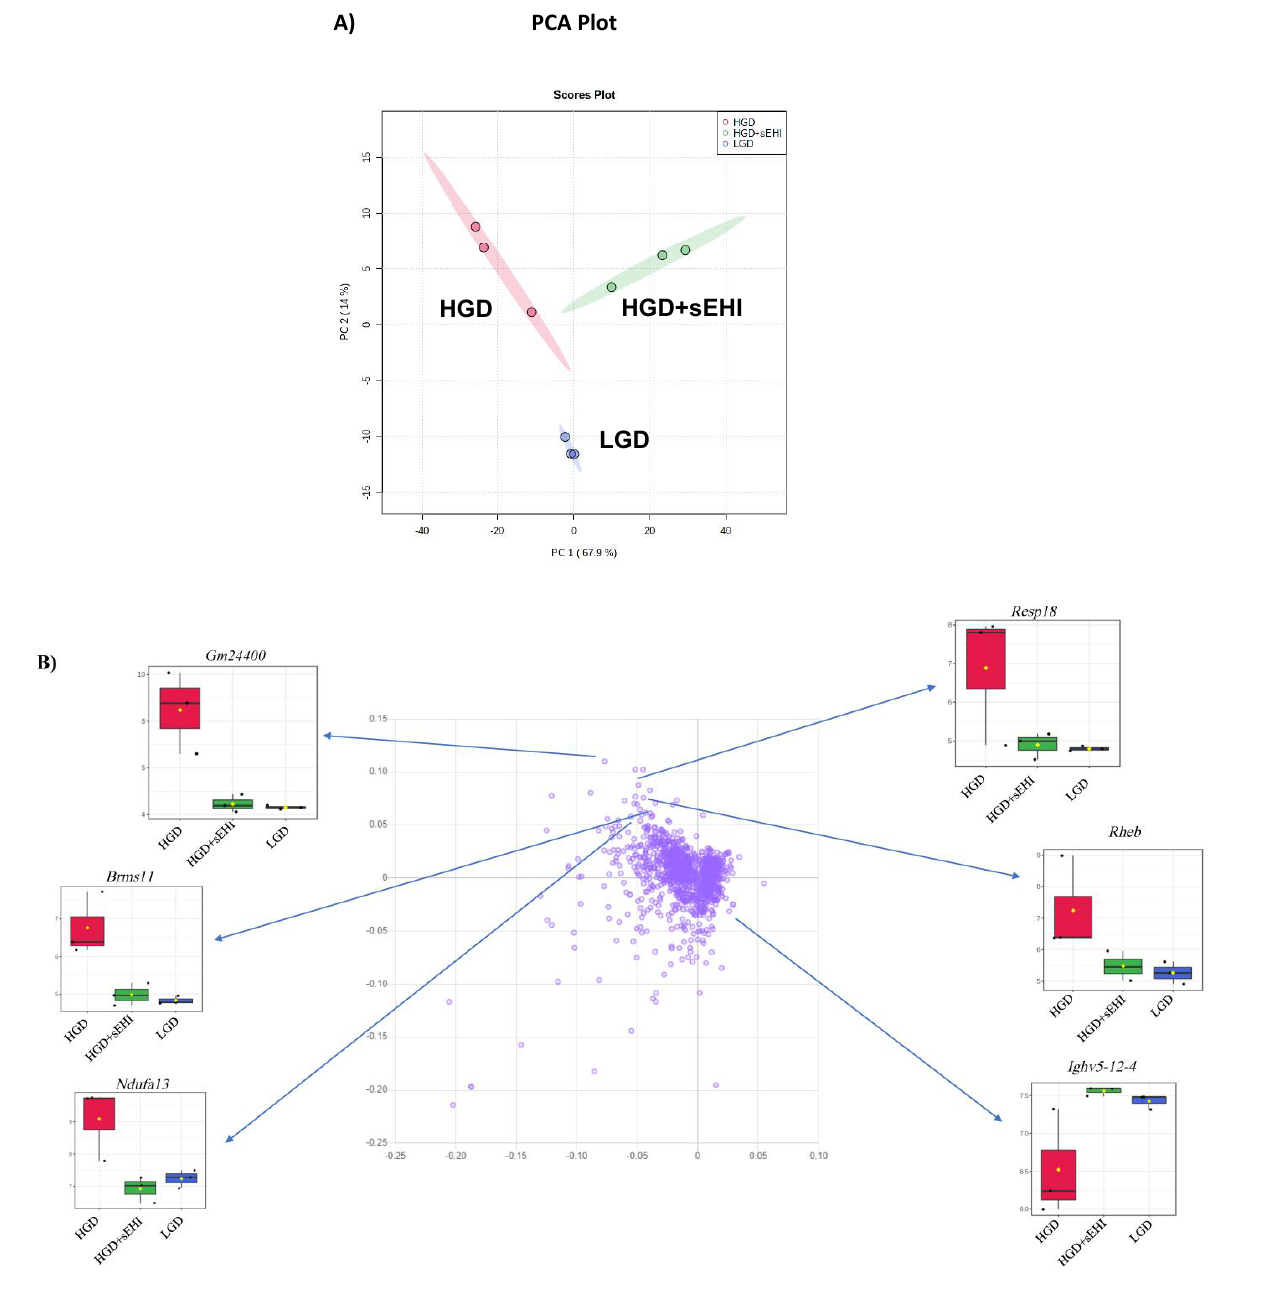
Figure 6. Principal Component Analysis (PCA) and loading plot of genes expressed in hippocampal microvessels for the high glycemic diet (HGD) with and without soluble epoxide hydrolase inhibitor (sEHI). ( A ) PCA scatter plot of the microarray data shows the trends of the expression profiles of the hippocampal microvasculature of the high glycemic diet with (HGD+sEHI, green circles) and without (HGD, red circles) the soluble epoxide hydrolase inhibitor compared to the low glycemic diet (LGD, blue circles). The PCA plot captures the variance in a dataset in terms of principal components and displays the most significant of these on the x and y axes. The percentages of the total variation that are accounted for by the 1st and 2nd principal components are shown on the x- and y-axes labels. The data are shown for three biological replicates for each dietary group. ( B ) Loading plot of genes (violet circles) relevant to the separation of PCA. Blue arrows show box plots with the expression levels of a few genes ( Gm24400, Resp18, Rheb, Brms1l, Ndufa13, Ighv5-12-4 ) that contribute to separation of the three dietary groups (HGD, HGD+sEHI, LGD). In the box plots, the black dots represent gene expression levels, the notch indicates 95% confidence interval around the median of each group, and the yellow diamond indicates the average gene expression of each group.